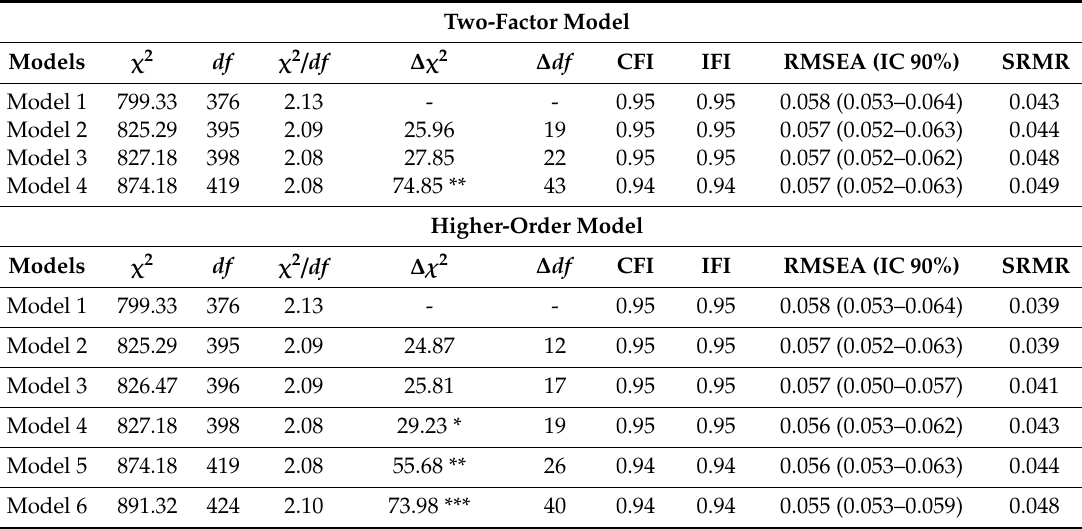
Table 4. Age Invariance Analysis. Two-Factor